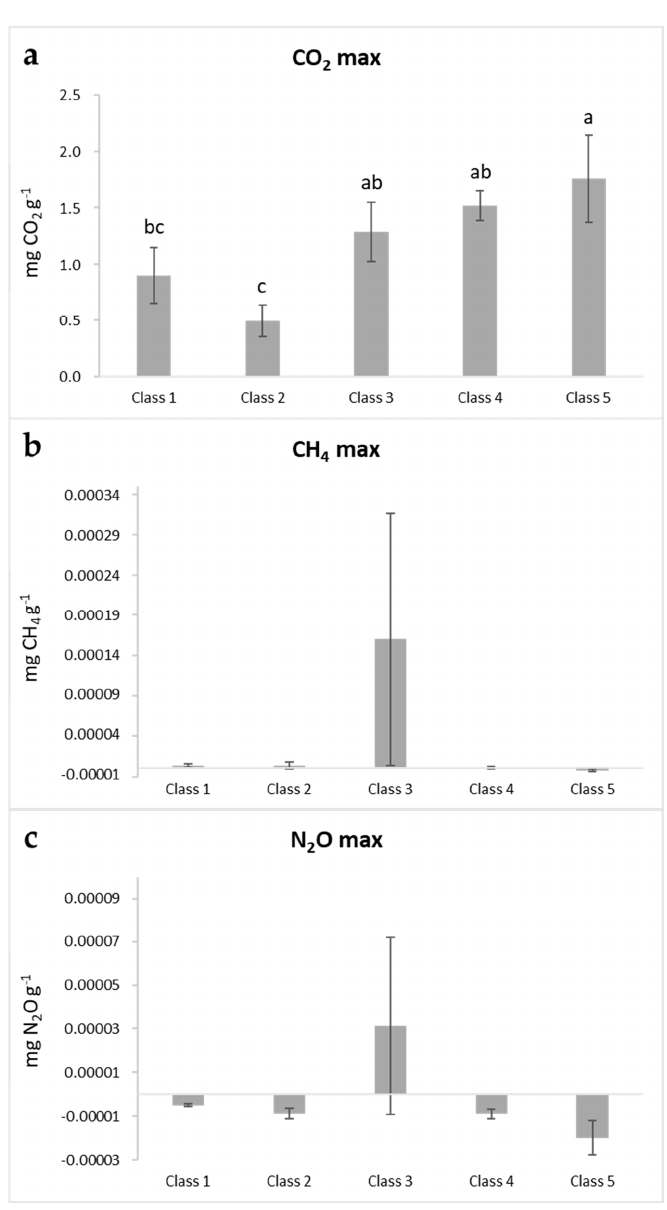
Figure 1. Maximum values of CO 2 ( a ); CH 4 ( b ); and N 2 O ( c ) production from the black pine deadwood cores of the different decay classes. Error bars are the standard errors of four replicates. Different letters indicate significant differences at p < 0.05 among means.